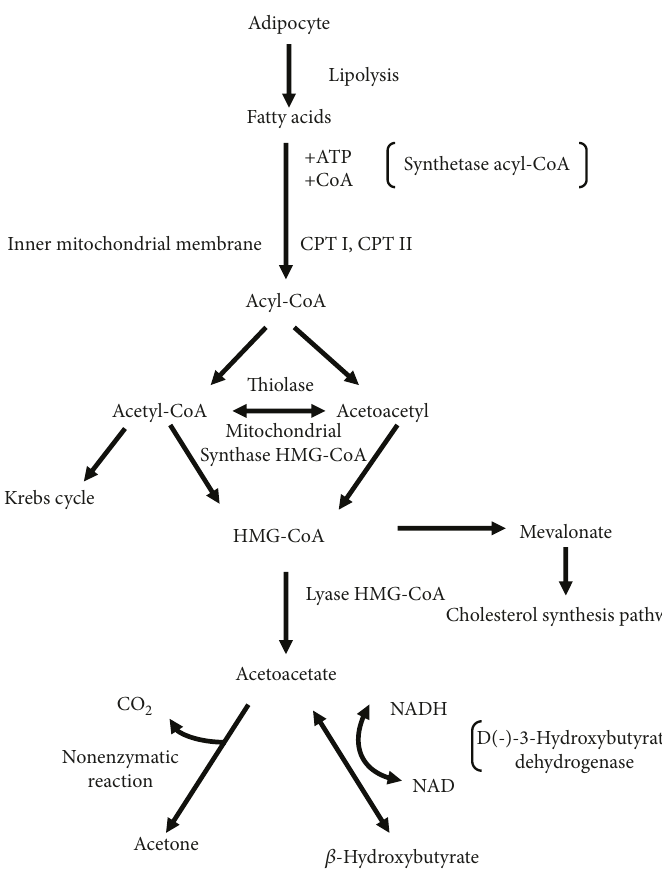
Figure 1: Ketogenesis